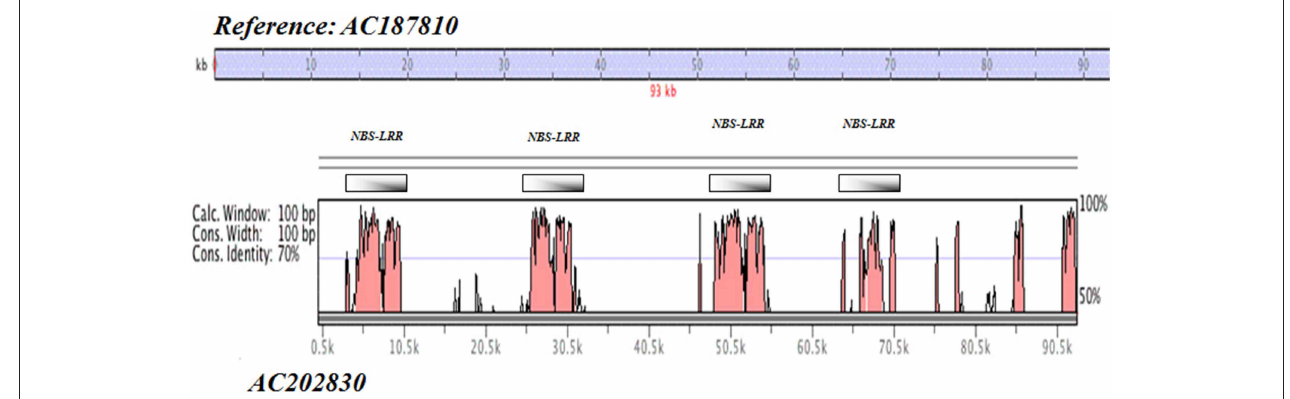
FIGURE 2 | Self-alignment of BAC clones in Upland cotton Chr 21. Percent identity plot of duplication harboring NBS-LRR resistance motifs (BAC clones AC187810 vs. AC202830 on Chr 21).